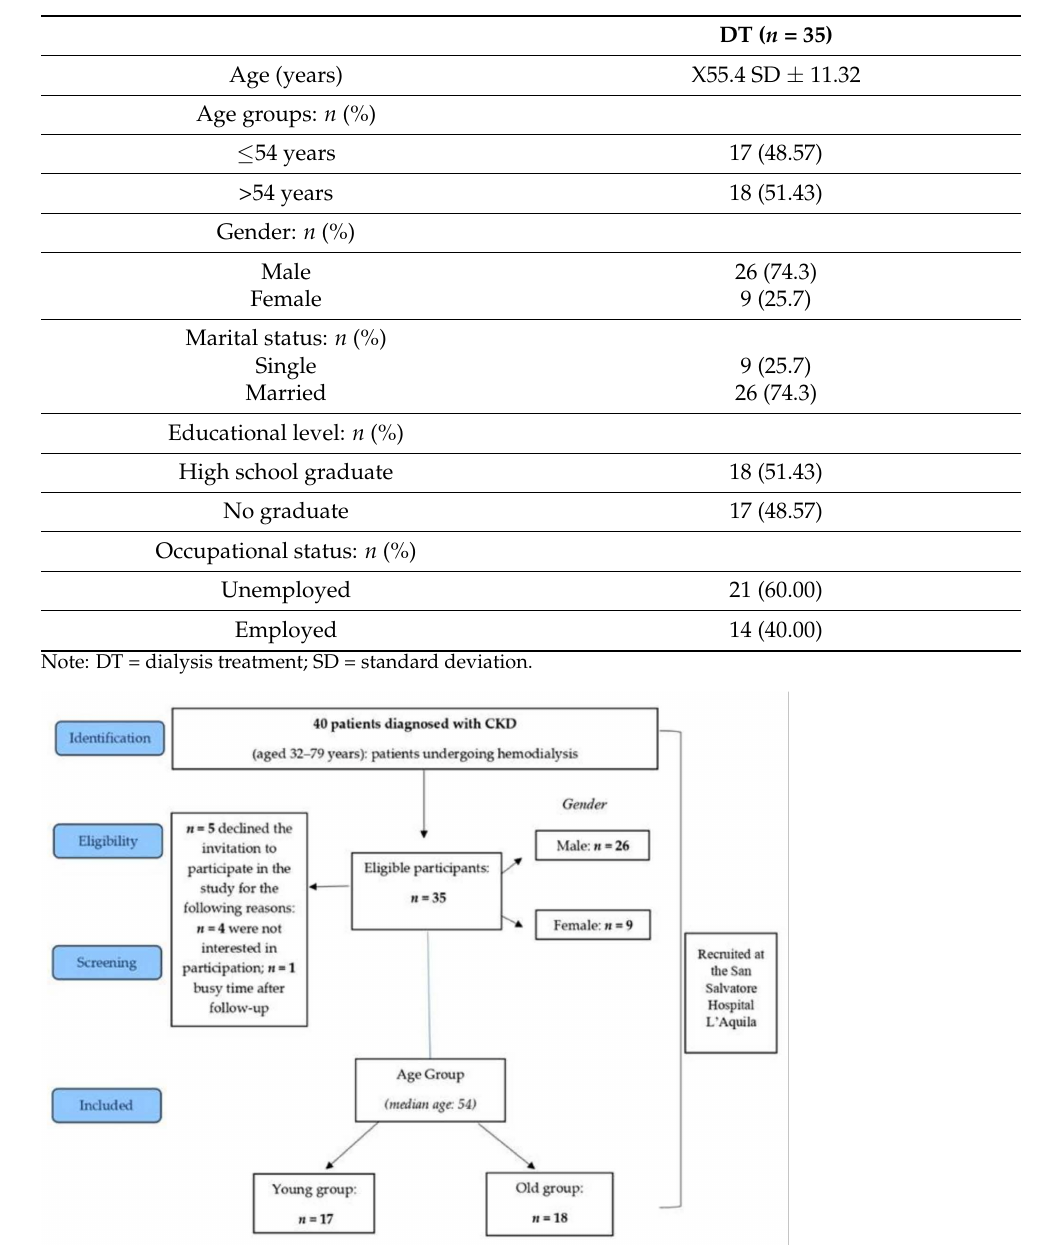
Table 1. Demographic characteristics of the sample.